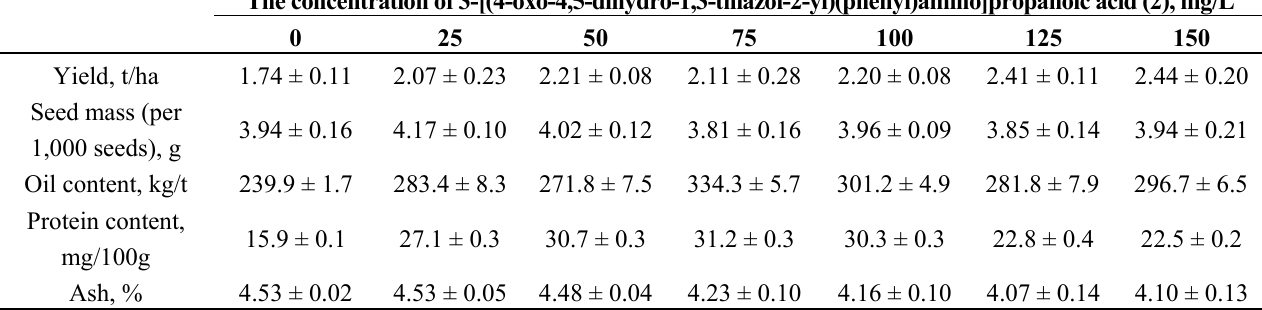
Table 3. The effect of 3-[(4-oxo-4,5-dihydro-1,3-thiazol-2-yl)(phenyl)amino]propanoic acid ( 2 ) on rapeseed yield and biochemical